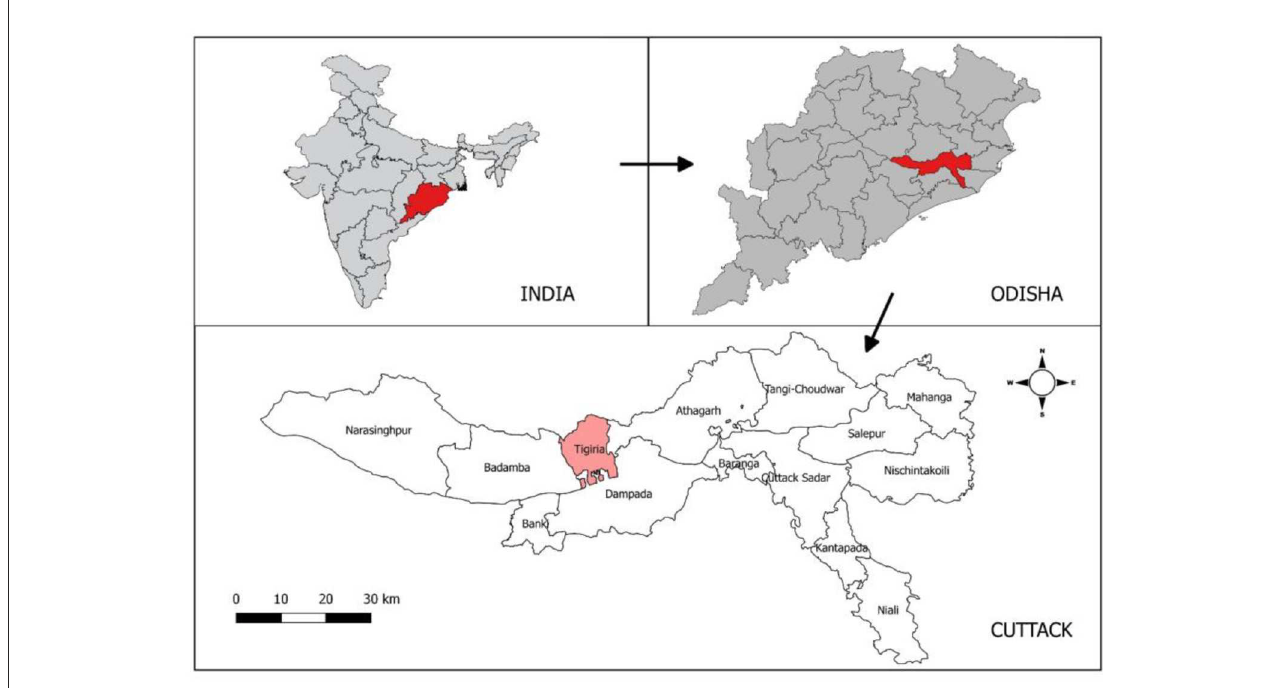
FIGURE1 Study area site of the KAP in Odisha,